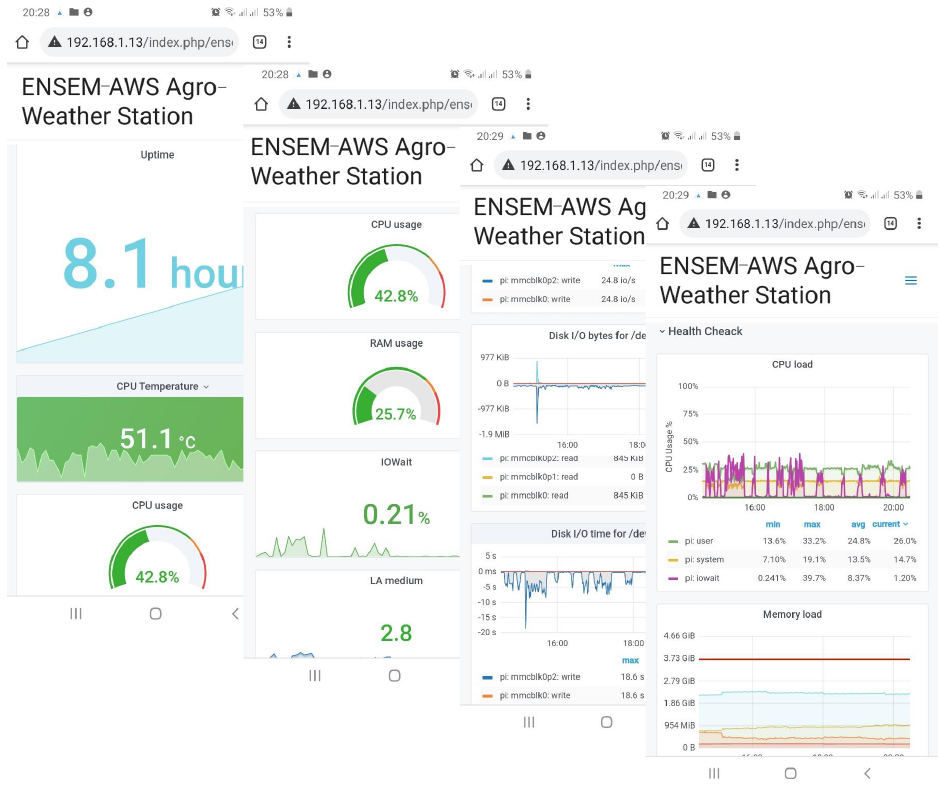
Figure 12. Remote access to the agro-weather station using